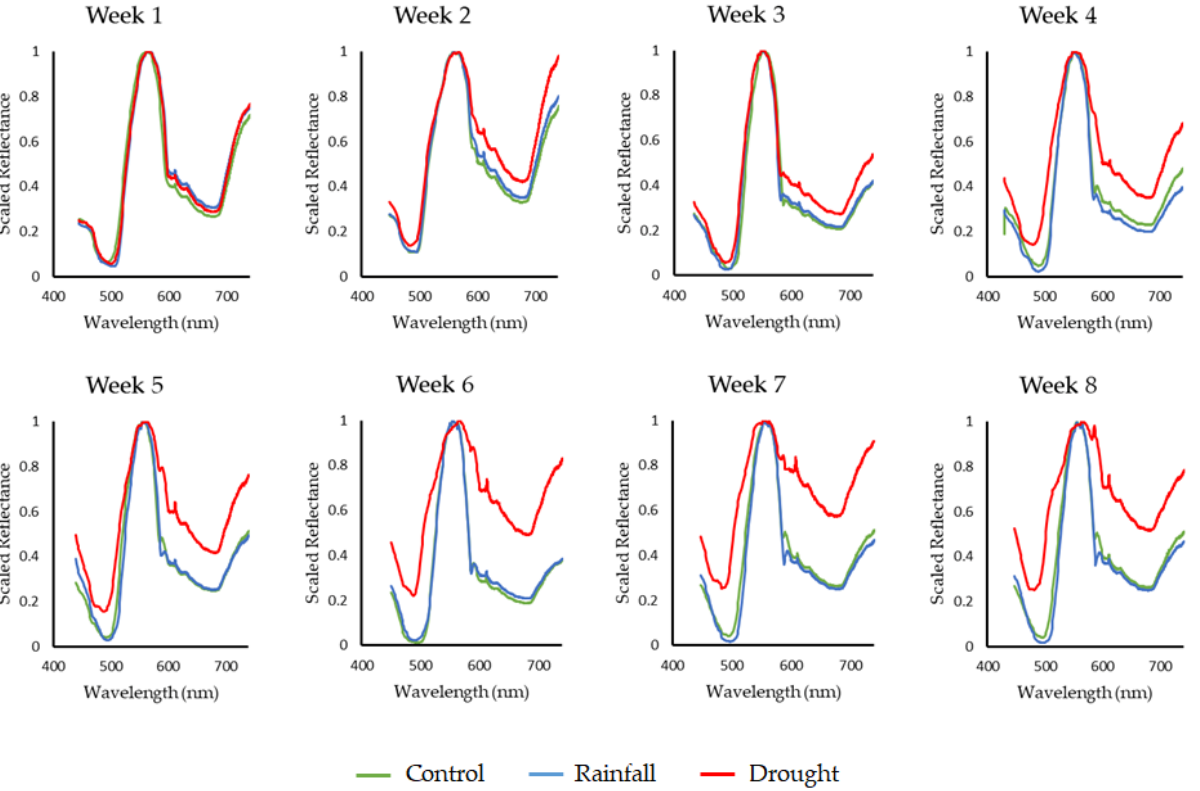
Figure 8. Sphagnum change over time observed for each group. Note the shift in spectral response for the drought group over the measurement period.